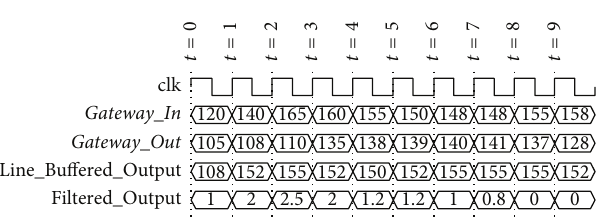
Figure 20: Simulation results showing the time interval taken to process the image pixels. Each clock pulse duration is 10ns. Each pixel requires one clock pulse to process from the FPGA boundary 𝐺𝑎𝑡𝑒𝑤𝑎𝑦 𝐼𝑛 to 𝐺𝑎𝑡𝑒𝑤𝑎𝑦 𝑂𝑢𝑡 together with the intermediary signal lines as probed, following the same rate (ref. Figure 7).